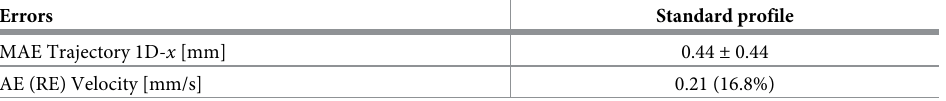
Table 1. The mean absolute error (MAE) is given for the distance in x -direction with its standard deviation (SD). Additionally, the absolute error (AE) along with the relative error (RE) of the velocity using the 3D regression line between t and t is also reported. M 1 M 2